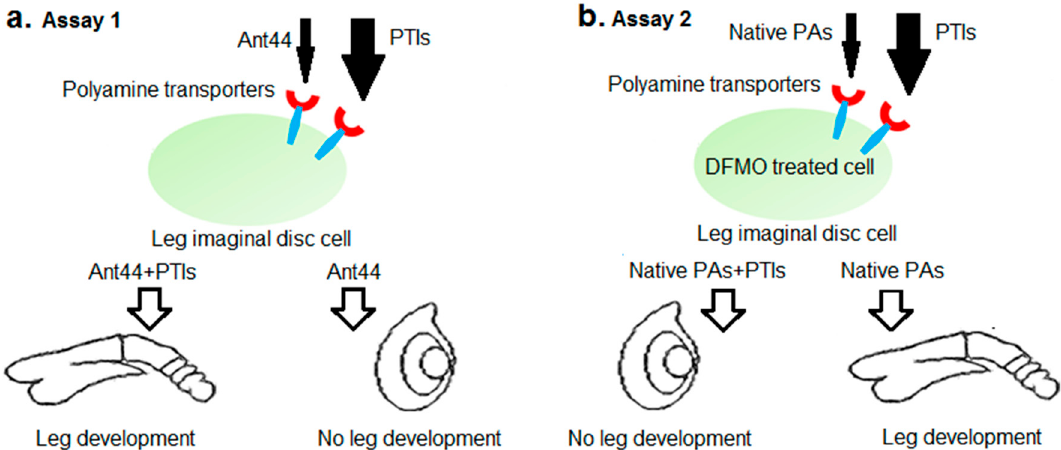
Figure 2. Drosophila assays used to characterize polyamine transport inhibitors. Native PAs: native polyamines; PTIs: polyamine transport inhibitors. ( a ) Assay 1: Undeveloped leg imaginal discs were incubated with ecdysone to promote development. In the presence of Ant44 ( 5 ), a toxic polyamine analog that targets the transport system, leg imaginal discs will not develop. The ability of candidate PTIs to rescue development of imaginal discs treated with Ant44 ( 5 ) was then assayed by monitoring and scoring the leg development process. ( b ) Assay 2: Leg imaginal discs treated with DFMO fail to develop in the presence of ecdysone. Uptake of exogenous native polyamines can rescue DFMO inhibition of disc development. The ability of candidate PTIs to block rescue of disc development in the presence of DFMO and native polyamines was tested.